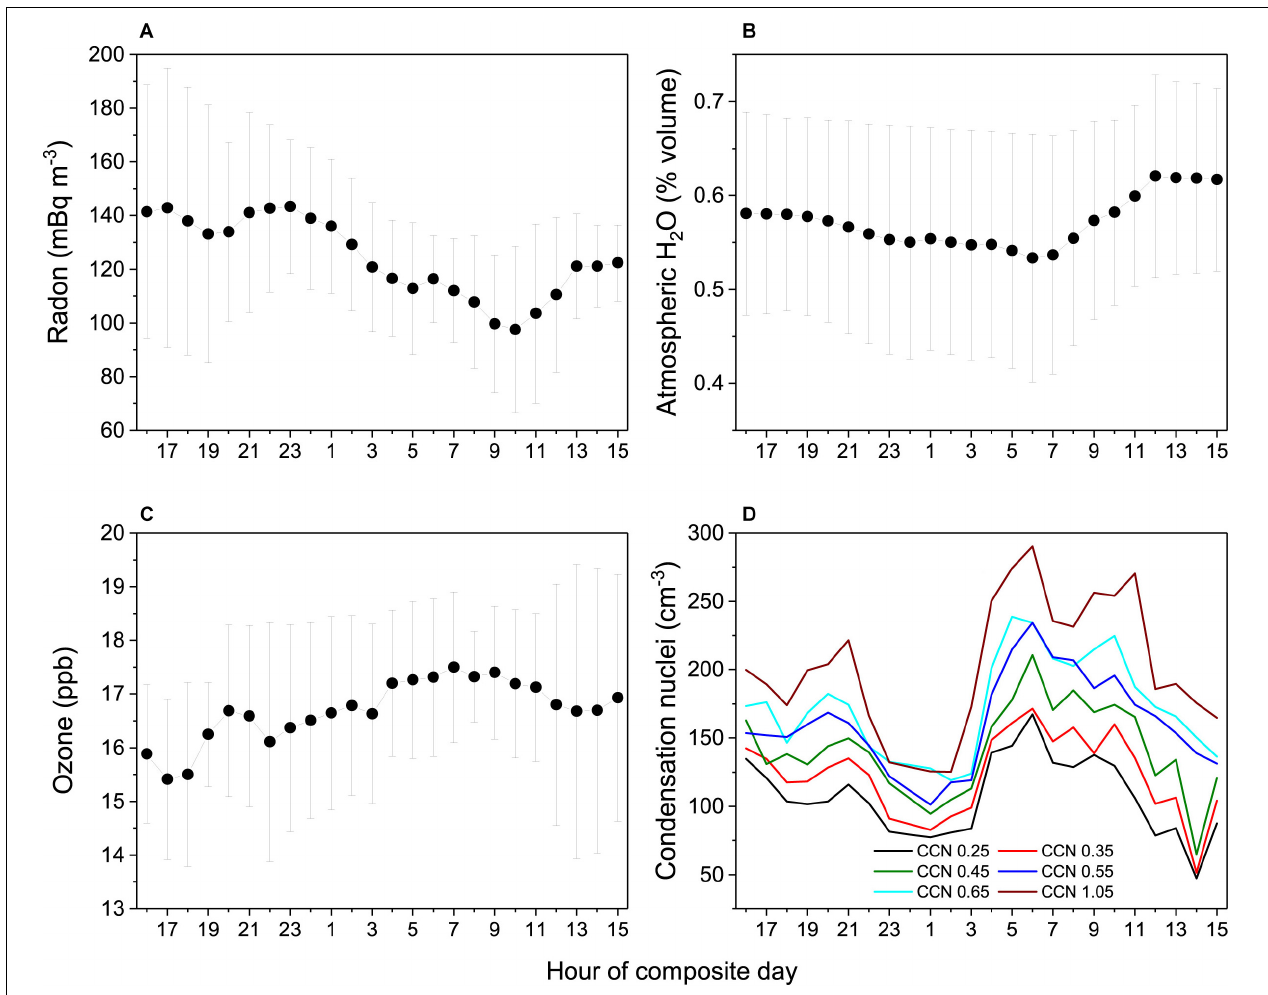
FIGURE 6 | Diurnal composites of (A) radon, (B) % volume of water, (C) ozone, and (D) CCN (cm − 3 ) within supersaturation ranges 0.25 – 1.05%, based on 5 days of katabatic outflow conditions. Whiskers represent hourly ± 1 σ for the 5 days